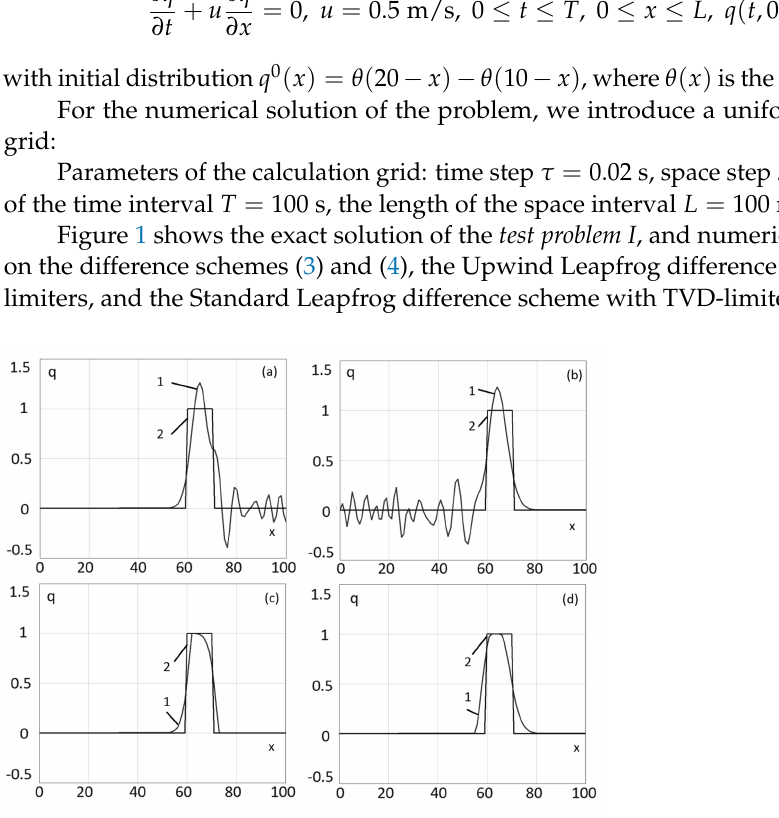
Figure 1. Solutions of the test problem I for time interval T = 100 s, based on the Upwind Leapfrog scheme ( a ), Standard Leapfrog scheme ( b ), Upwind Leapfrog scheme with TVD-limiters ( c ), and Standard Leapfrog scheme with TVD-limiters ( d ): 1—exact solution; 2—numerical